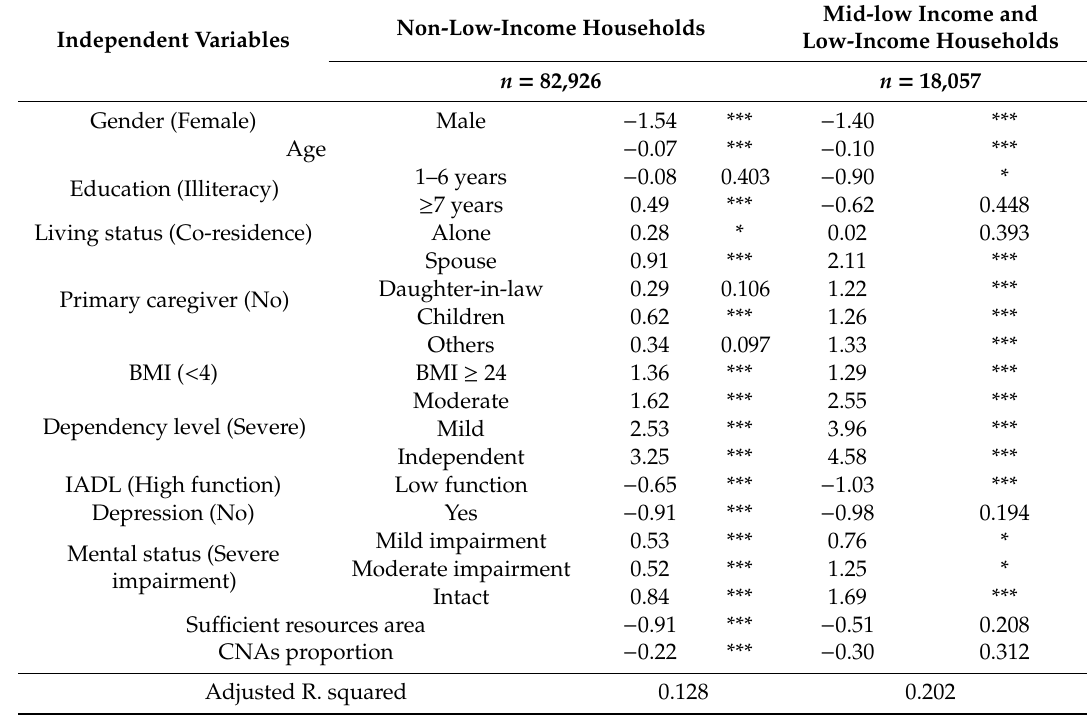
Table 3. Influencing factors of HCBS utilization stratified by social welfare